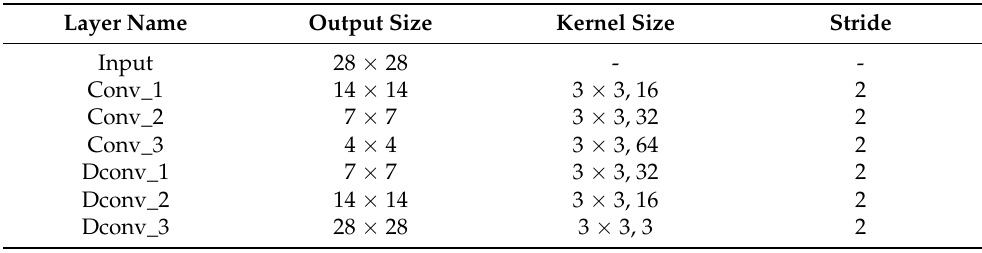
Table 4. Convolutional structure and parameters of the encoder and decoder in MemAE.